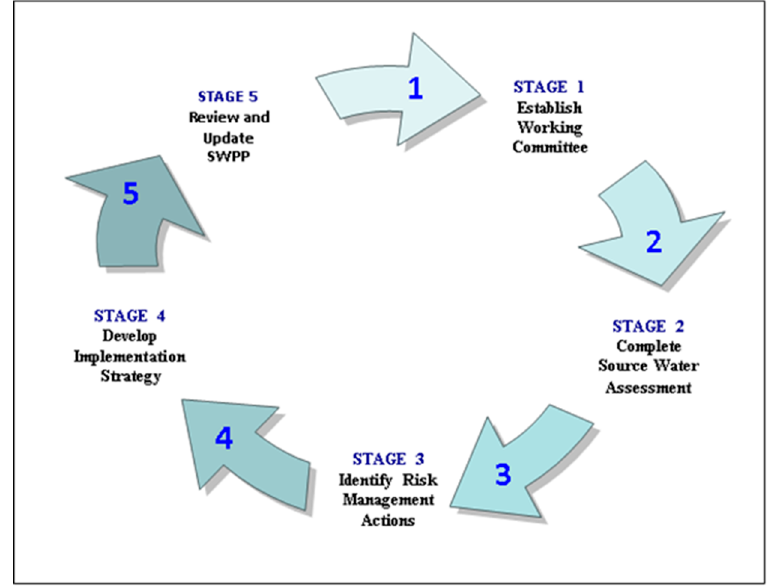
Figure 2. Source Water Protection Planning framework, redrawn from [42].